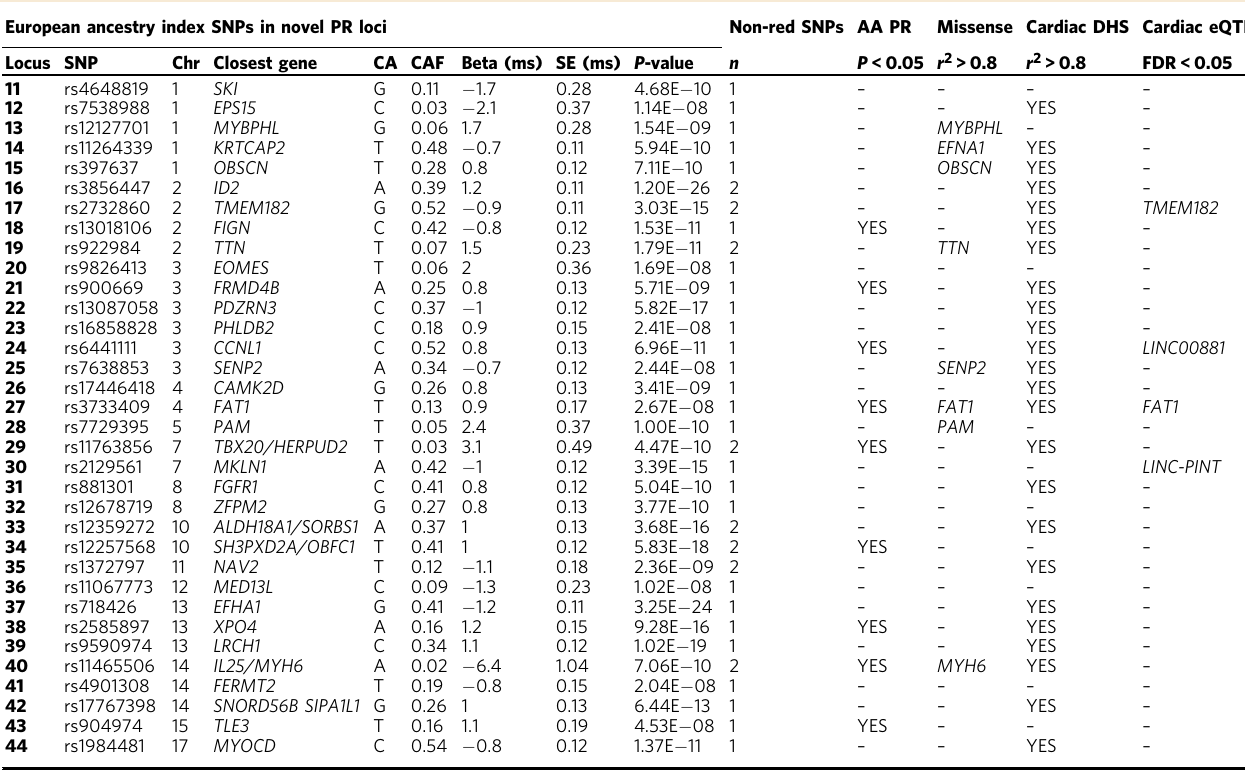
Table 2 Description of novel PR loci among those of European descent European ancestry index SNPs in novel PR